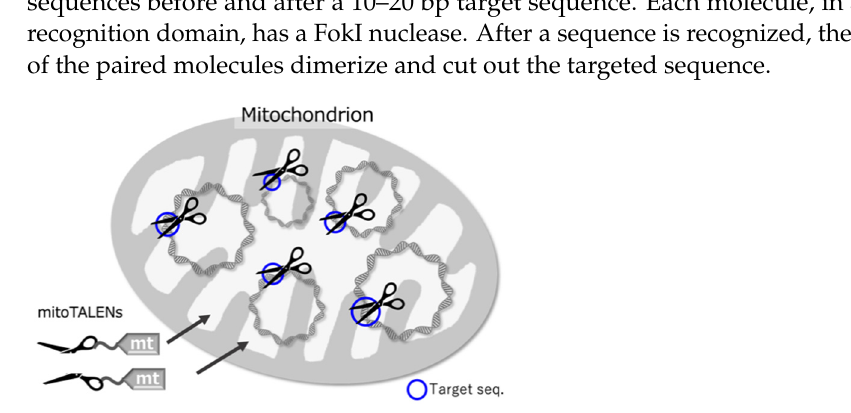
Figure 2. Schematic drawing of mitoTALENs in a mitochondrion. The mitoTALENs are introduced by a mitochondrial targeting sequence (mt), which is cleaved on entry. Each mitoTALEN can be represented as one scissor blade. When joined at the target site, they form a functional scissor-like nuclease.